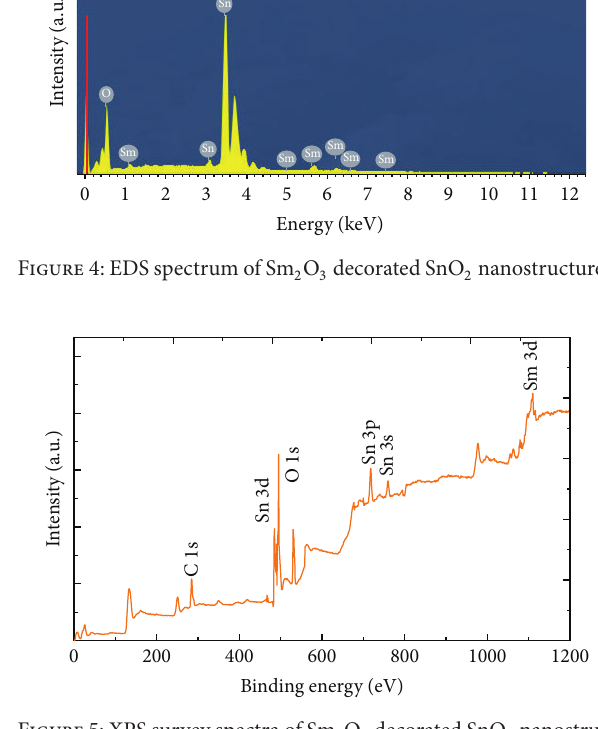
Figure 5: XPS survey spectra of Sm 2 O 3 decorated SnO 2 nanostruc-